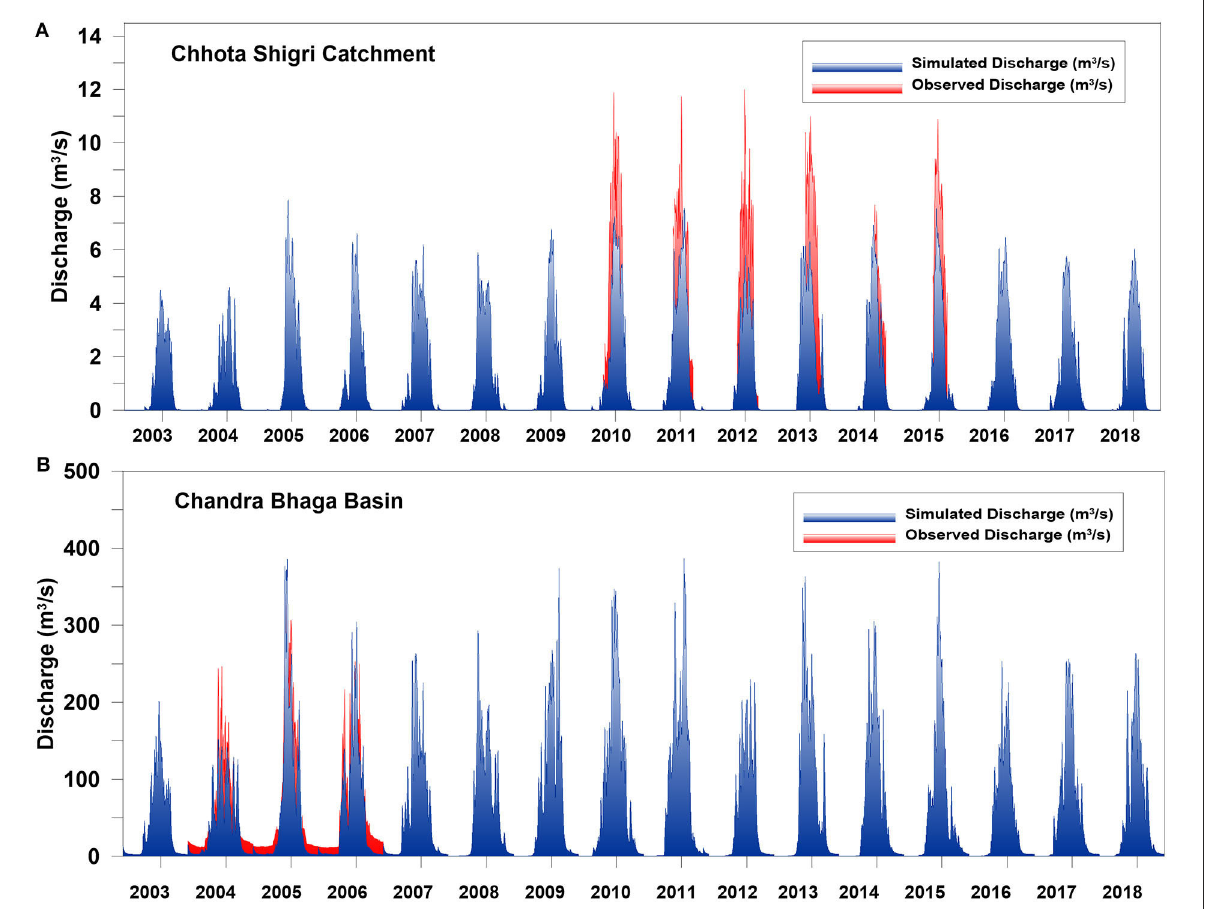
FIGURE7 Simulated discharge of Chhota Shigri Catchment (A) and Chandra-Bhaga Basin (B) over 2003–2018 (blue color). The observed discharge for Chhota Shigri Catchment (A) and Chandra-Bhaga Basin (B) in red color over 2010–2015 and 2004–2006, respectively.